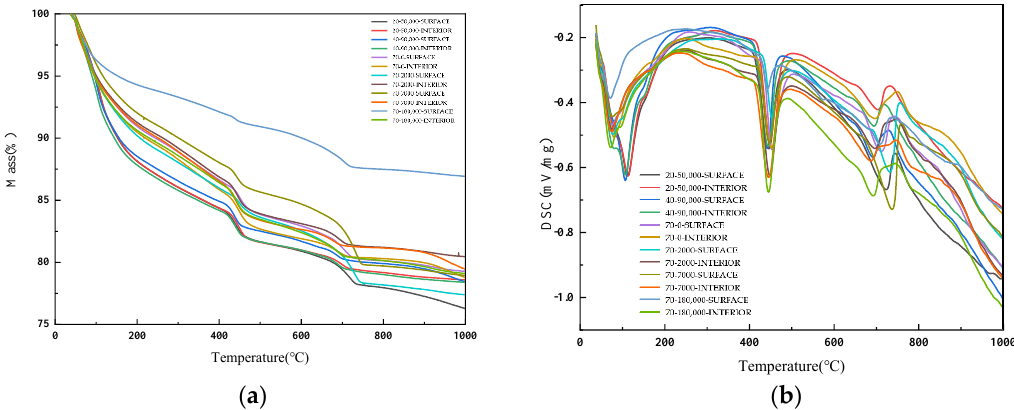
Figure 10. Thermogravimetry and differential scanning calorimetry (TG-DSC) curves of concrete at 180 days. ( a ) TG and ( b ) DSC. Table 3. The content of Ca (OH) 2 at 180 days.